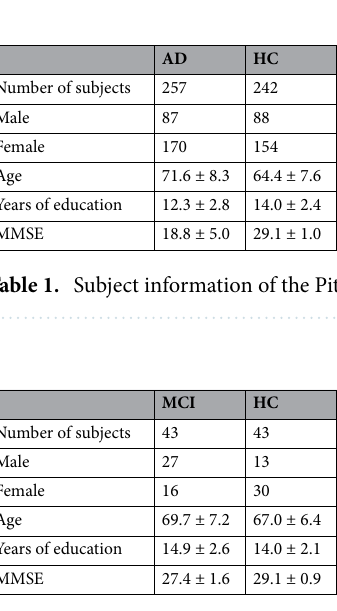
Table 2. Subject information of the Pitt dataset (MCI vs. HC).